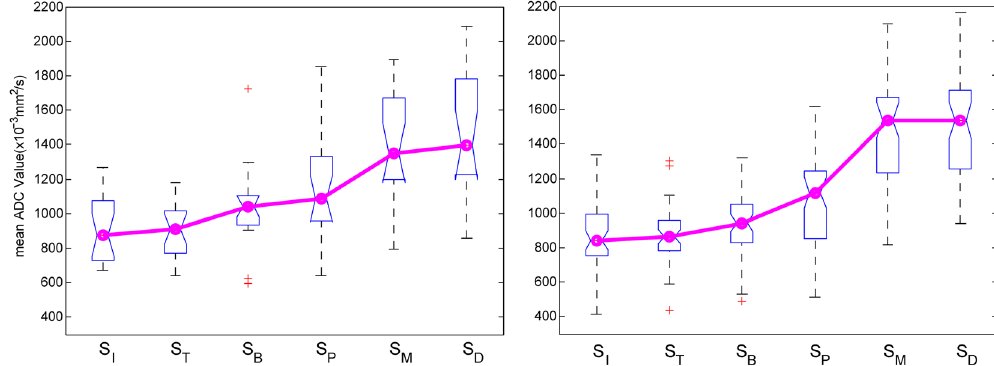
Figure 2. Comparison of median ADC values in six regions. An ascending trend (shown by the red trend line) for the ADC value was observed with ( a ) low Ki-67 proliferation status and ( b ) high Ki-67 proliferation status.